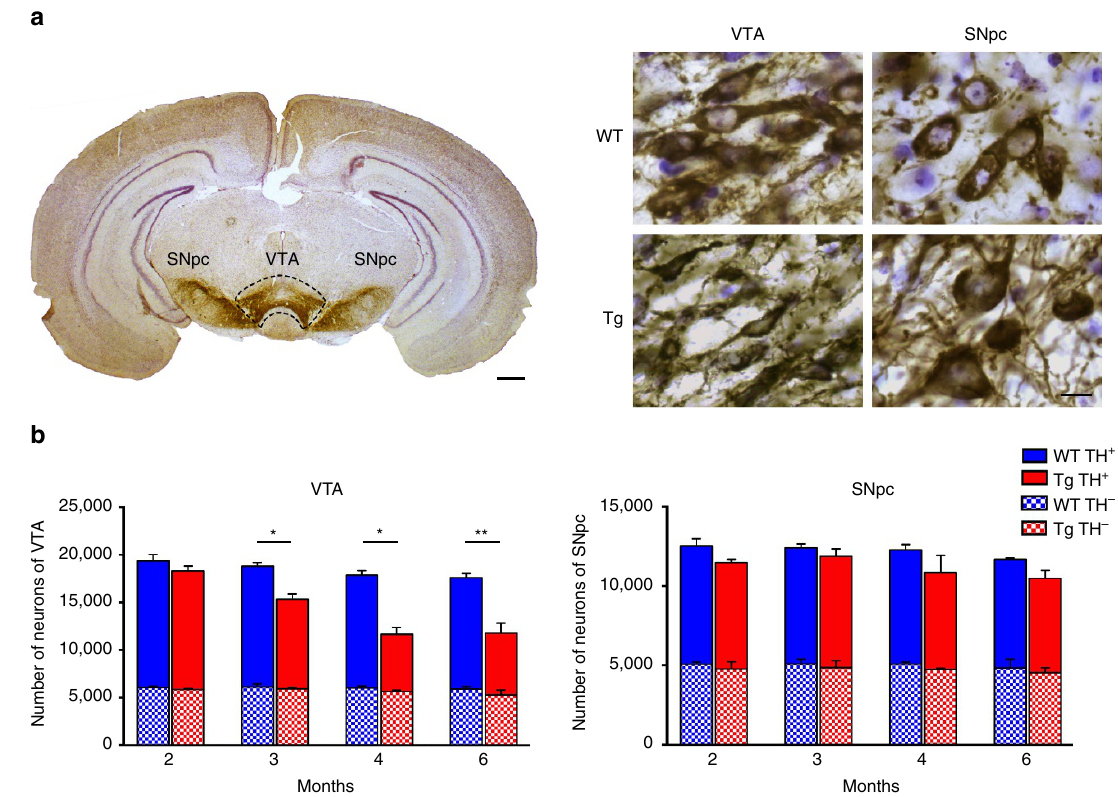
Figure 1 | Tg2576 mice show selective loss of VTA DAergic neurons starting at 3 months of age. ( a ) Coronal brain section from a 6-month-old WT mouse showing intense TH immunoreactivity (brown) in the VTA and SNpc. Sections were Nissl-counterstained (light blue). The dashed line indicates the anatomical boundaries separating the VTA from the SNpc (scale bar, 500 m m). On the right are higher magnification images (scale bar, 10 m m) showing TH þ and Nissl-counterstained neurons in the VTA and SNpc of WT and Tg2576 (Tg) mice ( n ¼ 7 mice per genotype; 9 sections per animal). ( b ) The bar graphs show stereological quantification of TH þ and TH (cid:2) cell numbers in the VTA and SNpc in WTand Tg2576 mice at the indicated ages ( n ¼ 7 mice per genotype per age; 9 sections per animal). DAergic neuronal loss in Tg2576 mice is selective for the VTA with the onset at 3 months of age (two-tailed unpaired t -test: 3 and 4 months, * P ¼ 0.003; 6 months, ** P ¼ 0.002). Data represent mean ±